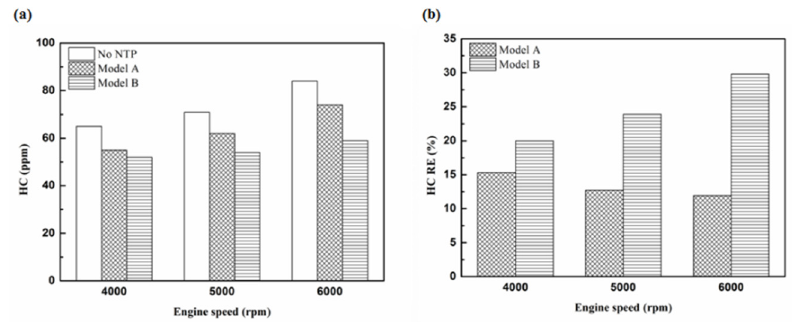
Figure 9. The HC ( a ) emission values and ( b ) RE of control voltage 5 V using platinum.